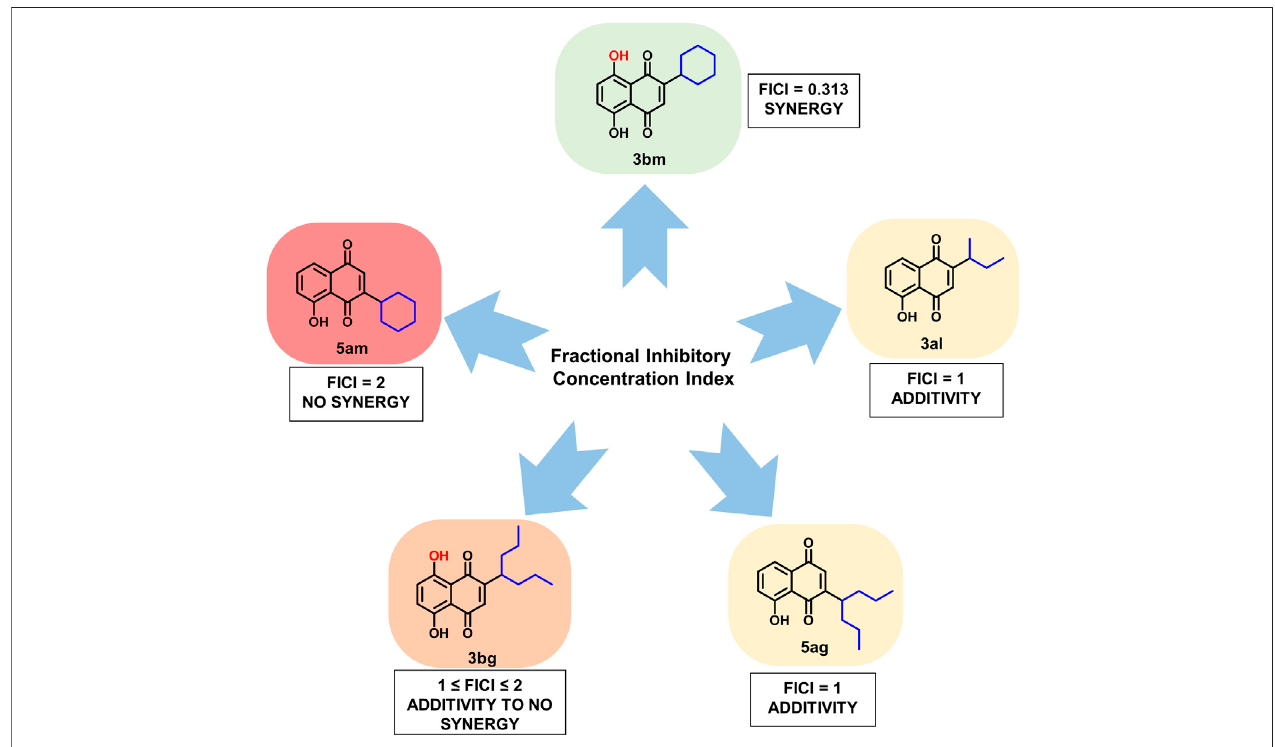
FIGURE 7 | FICI results for compounds 3bm , 3al , 5ag , 3bg , and 5am when added with cloxacillin or vancomycin on MRSA strains.